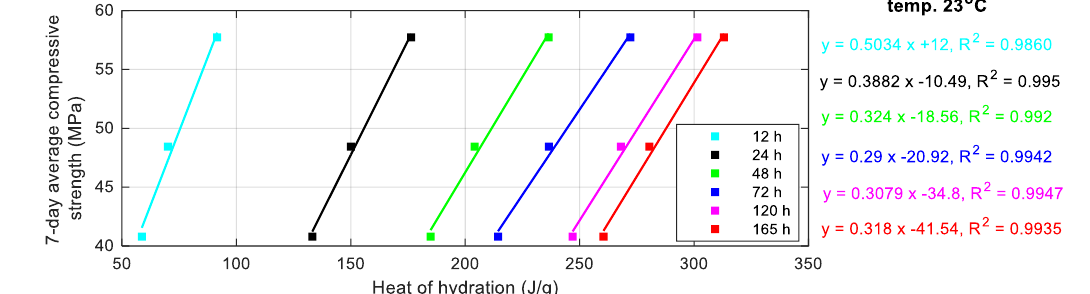
Figure 6. Correlation of 7-day strength and heat of mortars cured at 23 °C.